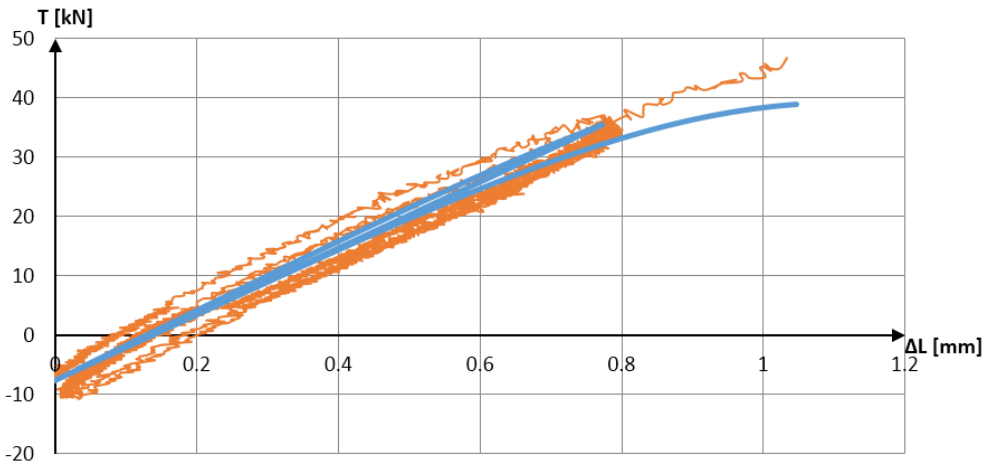
Figure 20. Numerical ( blue ) and experimental comparison for joint sample “II” ( orange ).